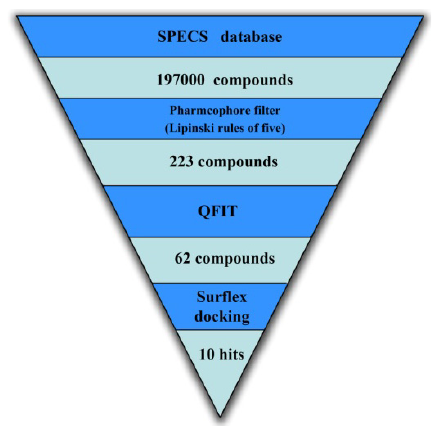
Figure 5. Virtual screening